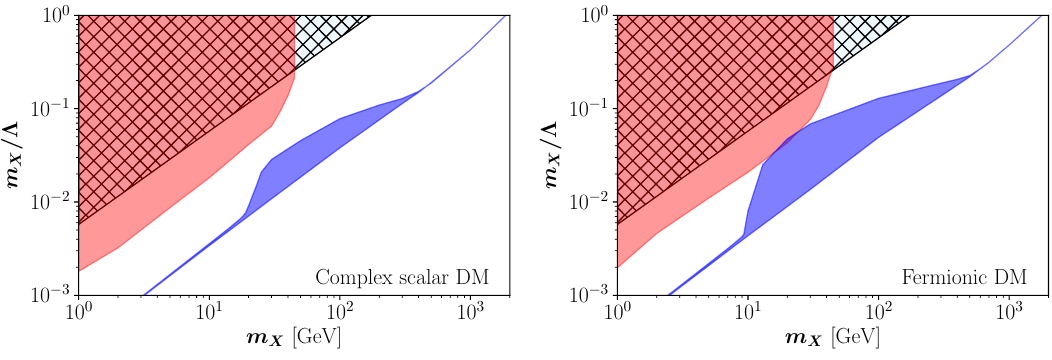
Figure 10 . The red shaded area represents the excluded region in the ( m X ; m X = (cid:3)) plane for scalar DM (left) and fermionic DM